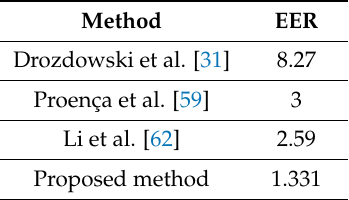
Table 9. Comparative EERs on CASIA-Iris-Thousand database (unit: